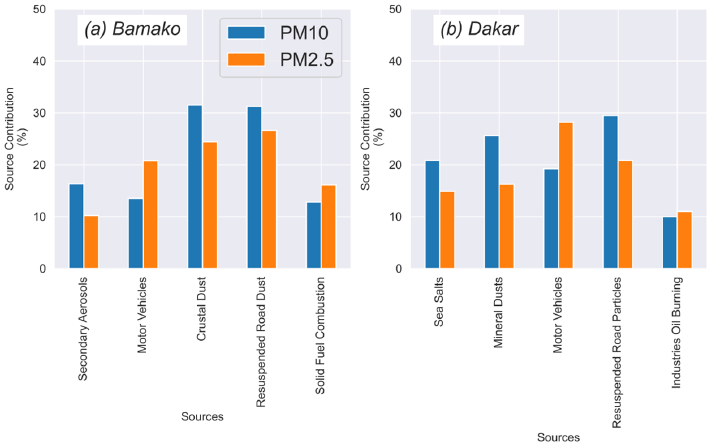
Figure 8. PM 10 and PM 2.5 source contributions estimated by PMF in ( a ) Bamako and ( b )